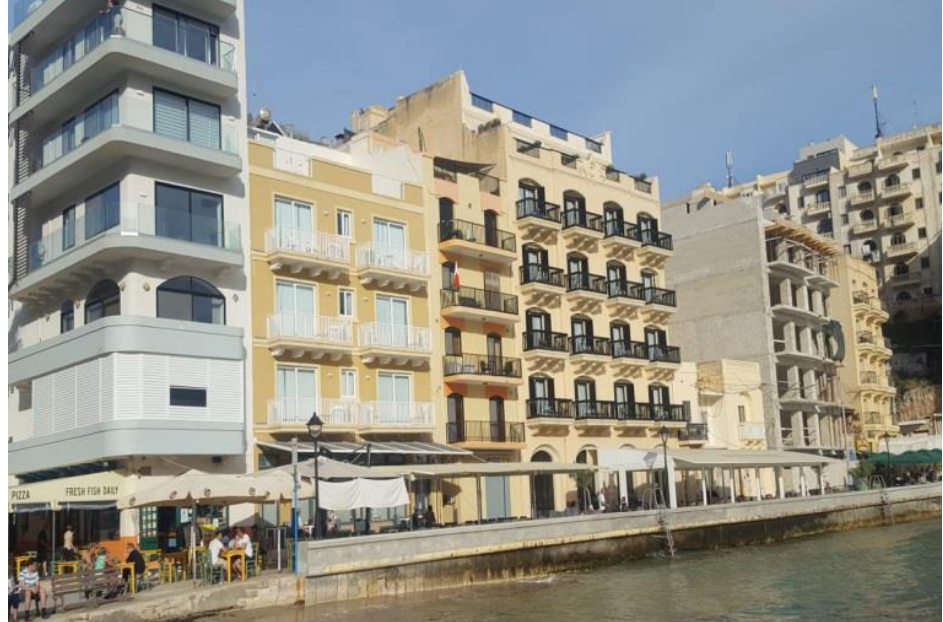
Figure 5. Businesses located along the promenade of Xlendi Bay.